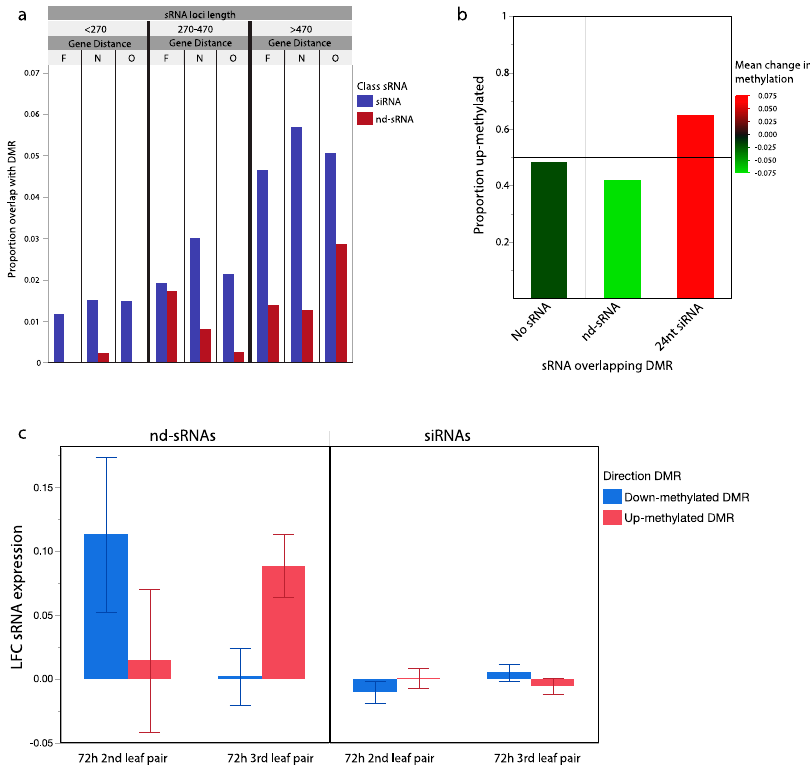
Figure 4. sRNA loci and transgenerationally di ff erentially methylated genomic regions. ( a ) Proportion of siRNA and nd-sRNA loci that overlap with regions previously identified as di ff erentially methylated in the o ff spring of wounded plants. sRNA locus types sorted into groups of similar size and similar distance from protein coding regions (Far, F: > 5 kb, Near, N < 5 kb, Overlapping, O). Longer sRNA loci near but not overlapping with genes had the highest frequency of overlap with genomic regions di ff erentially methylated in response to parent leaf wounding. siRNA loci overlap at higher frequency than nd-sRNA loci ( p < 0.001) with regions di ff erentially methylated in response to parent leaf wounding. ( b ) Di ff erentially methylated regions overlapping with siRNA loci were more likely to have increased methylation in the progeny of wounded plants (0.66 up, 0.34 down), while those overlapping with nd-sRNA show the opposite pattern (0.42 up, 0.58 down) ( p < 0.001, Chi Sq. = 75.21). Color-coded based on mean methylation change in each set of overlapping di ff erentially methylated regions. ( c ) Di ff erentially methylated regions overlapping with nd-sRNA loci show evidence of being associated with changes in sRNA abundances 72 h after leaf wounding. In the wounded 2nd leaf pair, there was an increase in sRNA abundance from sRNA loci overlapping with regions that were shown to be down-methylated in the next generation, while in the 3rd leaf pair there was an increase in sRNA abundance from sRNA loci in regions that were shown to be up-methylated in the next generation ( p = 0.009). Error bars: +/ − SE.